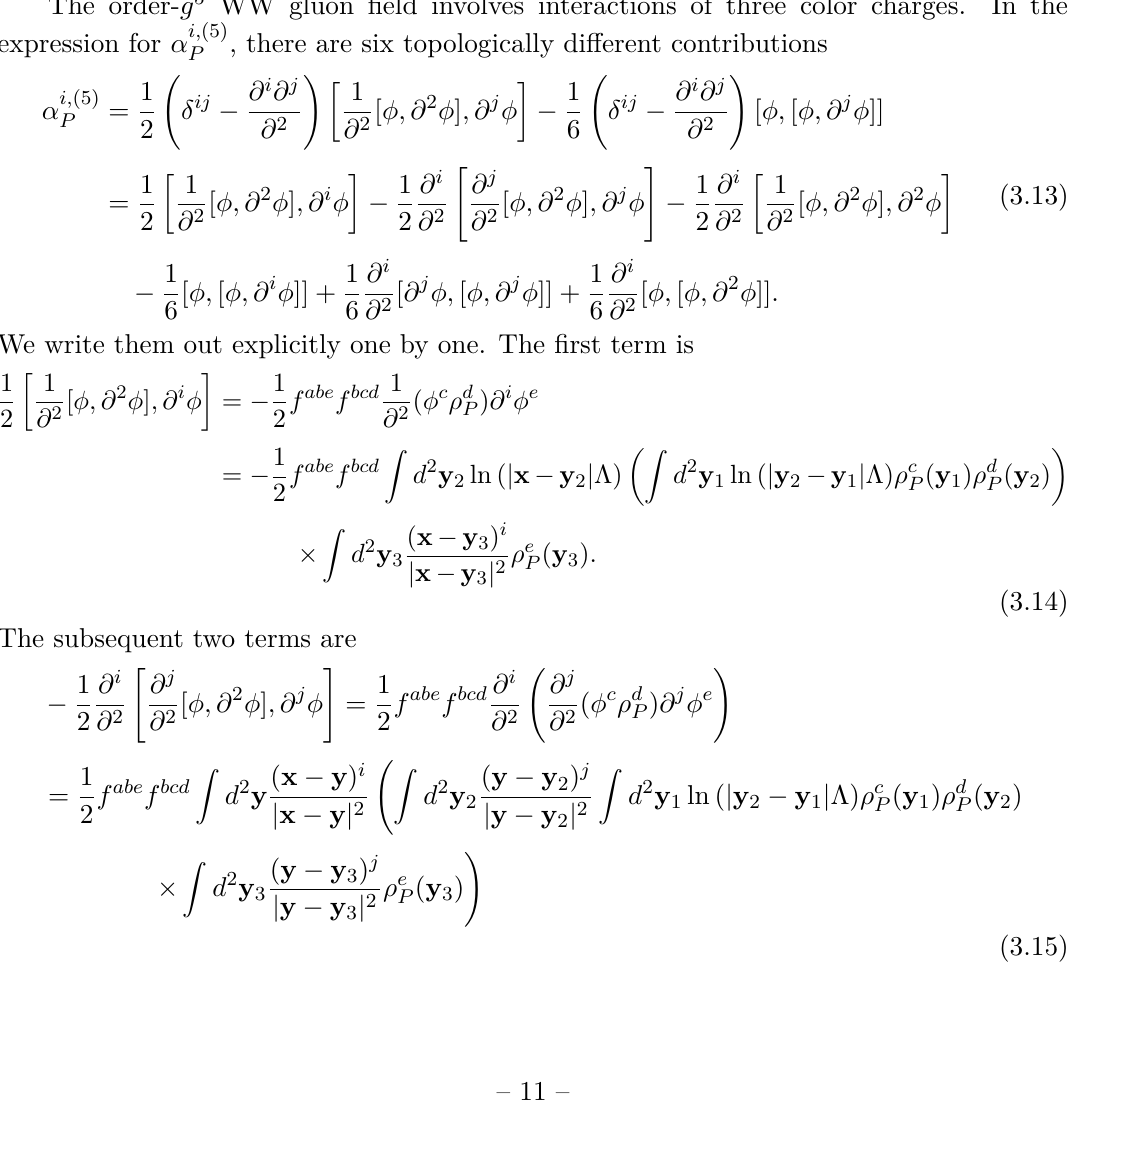
Figure 5 . The order- g 3 WW gluon field α i,a, (3) sources at transverse positions y